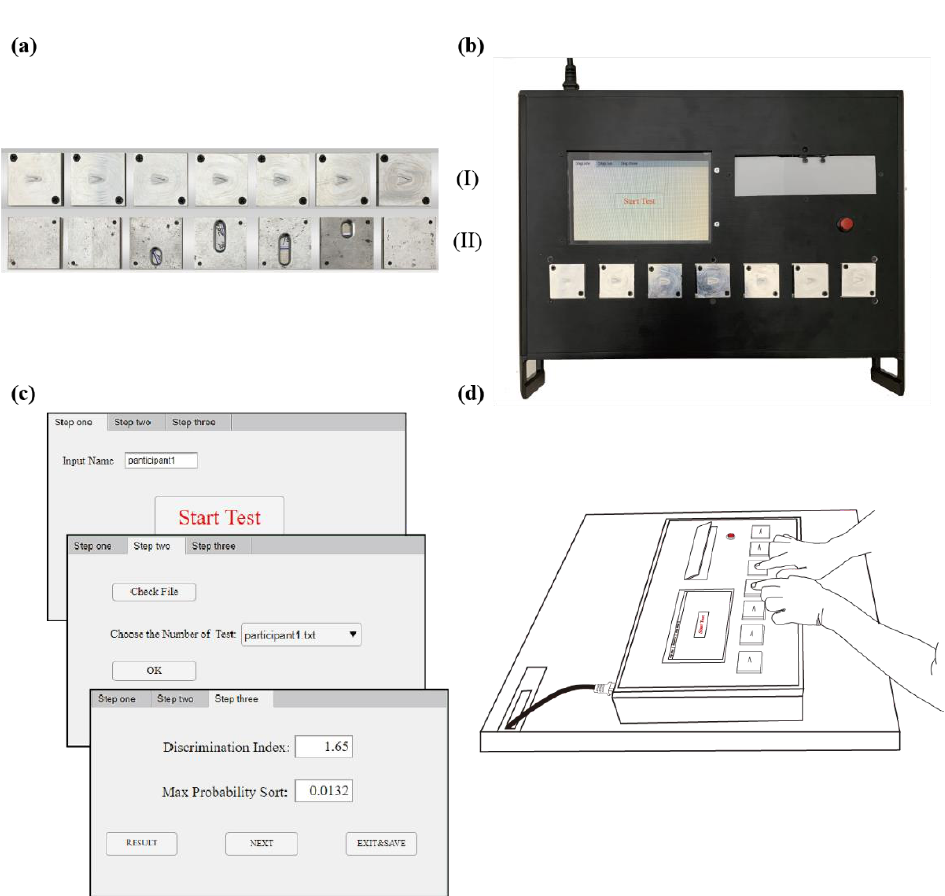
Figure 8. The implementation of the system: ( a ) angular stimulus module: the raised-angle drawing (I) on the front side and different trigger keycodes (II) on the backside; ( b ) interface design of the haptic angle device; ( c ) software interface to operate in the experiment and ( d ) operation of the angle sorting device by the participant in the experiment.